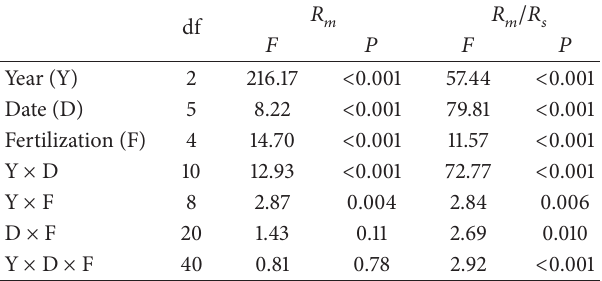
Table 1: Results ( 𝐹 and 𝑃 values) of repeated measures ANOVAs on the effects of nutrient fertilization (F) and year (Y) on soil microbial respiration ( 𝑅 𝑚 ) and the contribution of 𝑅 𝑚 to 𝑅 𝑠 ( 𝑅 𝑚 /𝑅 𝑠 ), with measuring date (D) as repeated variables,